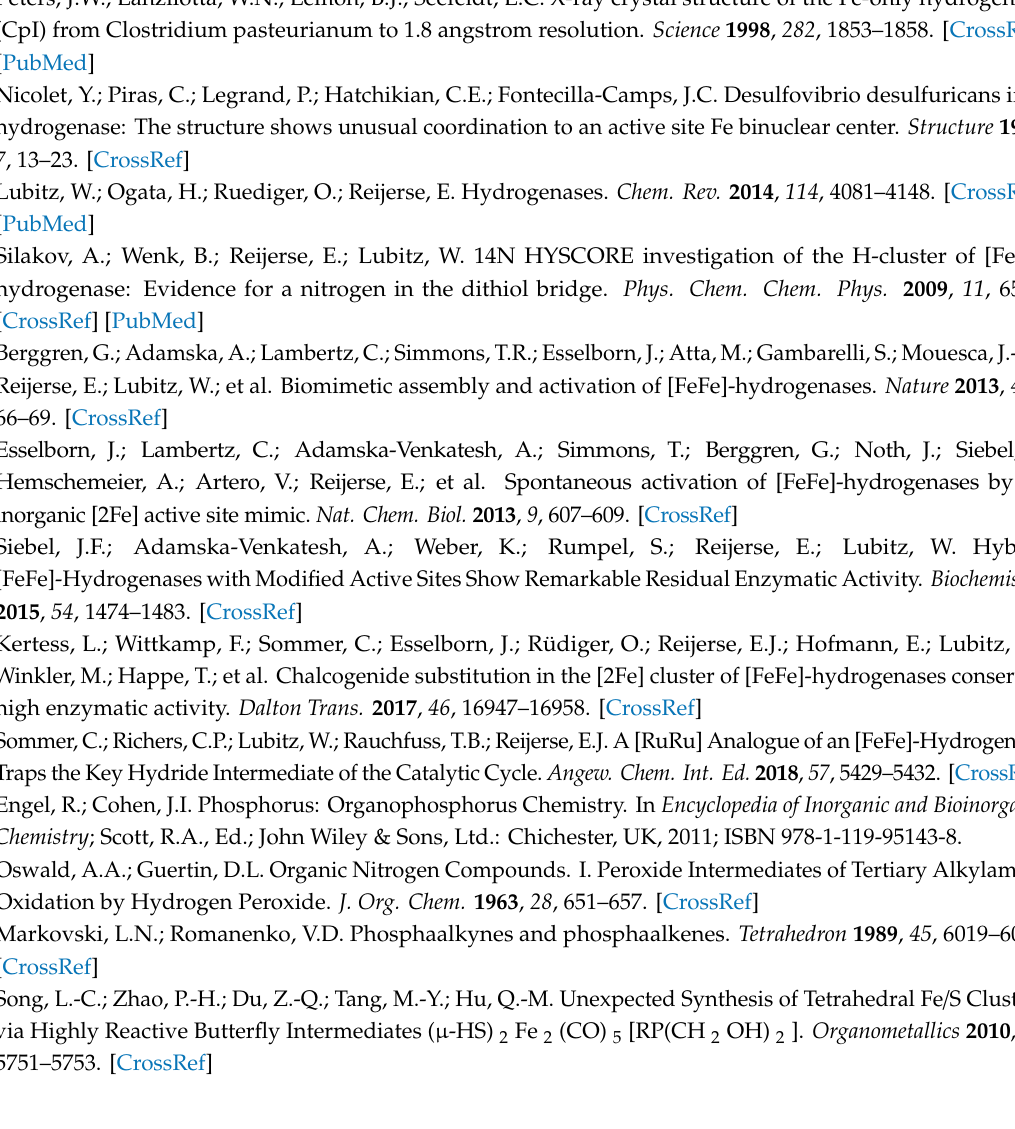
Computational Methodology, Figure S1: Complete asymmetric unit of compound 12-OMe, Figure S2: Molecular structure of 12-Me, Figure S1: IR spectra of compounds 12-R in presence of 0–50 equivalents of HBF 4 (33% in H 2 O) in acetonitrile at room temperature, Figure S4: DFT derived IR spectra of 12-Me in its neutral and protonated forms, Figure S5: Cyclic voltammograms of P(O)OMe (12-OMe) in absence and presence of HBF 4 (33% in H 2 O), Figure S6: IR-di ff erence spectrum of the reduction of 12-OEt, Figure S7: Comparison of IR-Spectra of 12-OEt, [12-OEt] − and [12-OEt] − after addition of 2 equivalents HOAc, Figures S8-S52: NMR Spectra of compounds 1–10. Table S1: Crystallographic data and refinement parameters of compounds